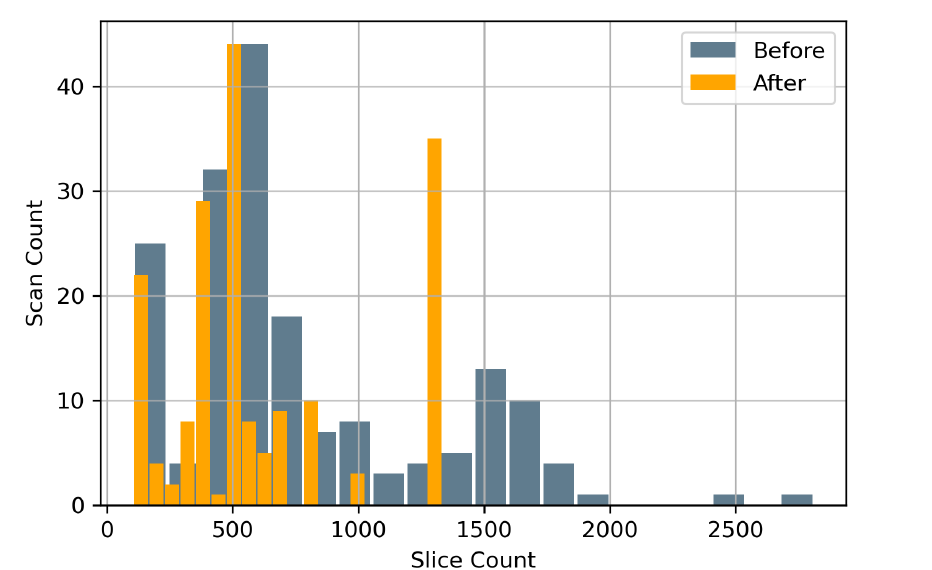
Figure 3. CT Image Slice Count Distribution before and after removal of scans 40 cm below the craniocaudal